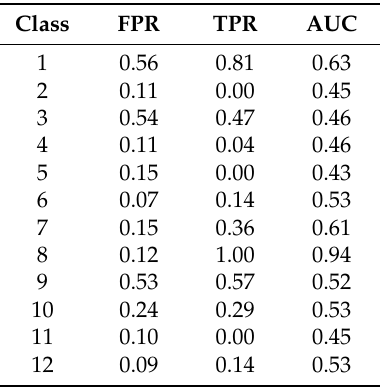
Table 4. Obtained TPRs vs. FPRs, for ROC curves, by the parallel computing accelerated GA, where for the 12 classes the AUCs obtained are also